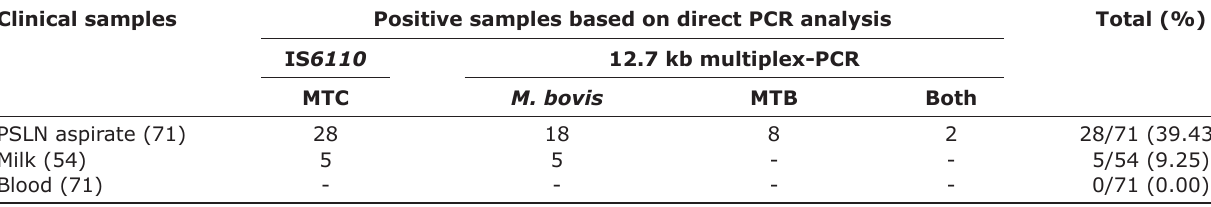
Table-2: Direct PCR-based analysis of clinical samples from tuberculin reactors. Clinical